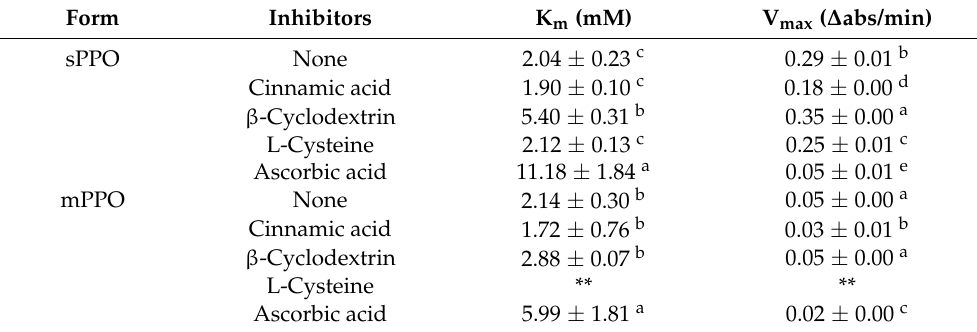
Figure 4. Substrates versus velocity plots based on peach ( A ) sPPO- and ( B ) mPPO-catalyzed CA oxidations in the presence and absence of different inhibitors. Table 2. Comparison of kinetic parameters obtained from sPPO- and mPPO-catalyzed